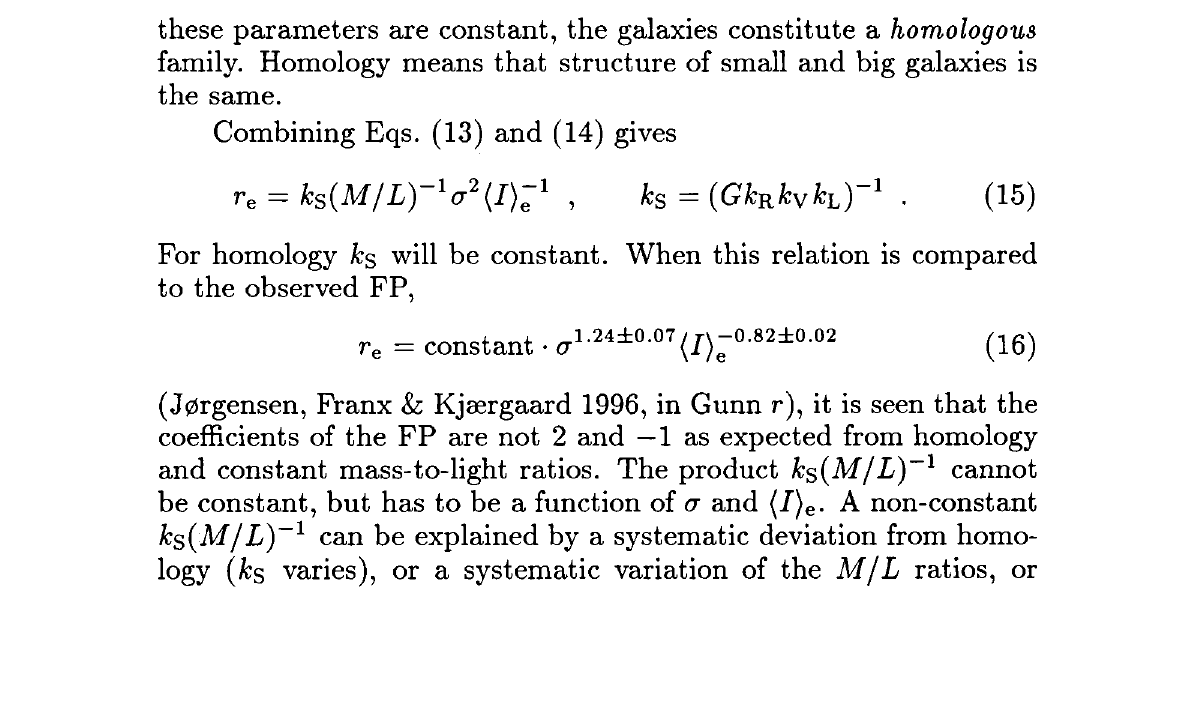
17. Illustration of the effect of the velocity dispersion a. The Fig. panel shows a K giant star in our own Galaxy. This star is representative of the stellar populations in E or SO galaxies. The two lower panels show E or SO galaxies in the Hydra I cluster. The M gb absorption line triplet at 5177 A (rest frame) is broadened in the galaxy spectra. The instrumental resolution is 79 km/s.